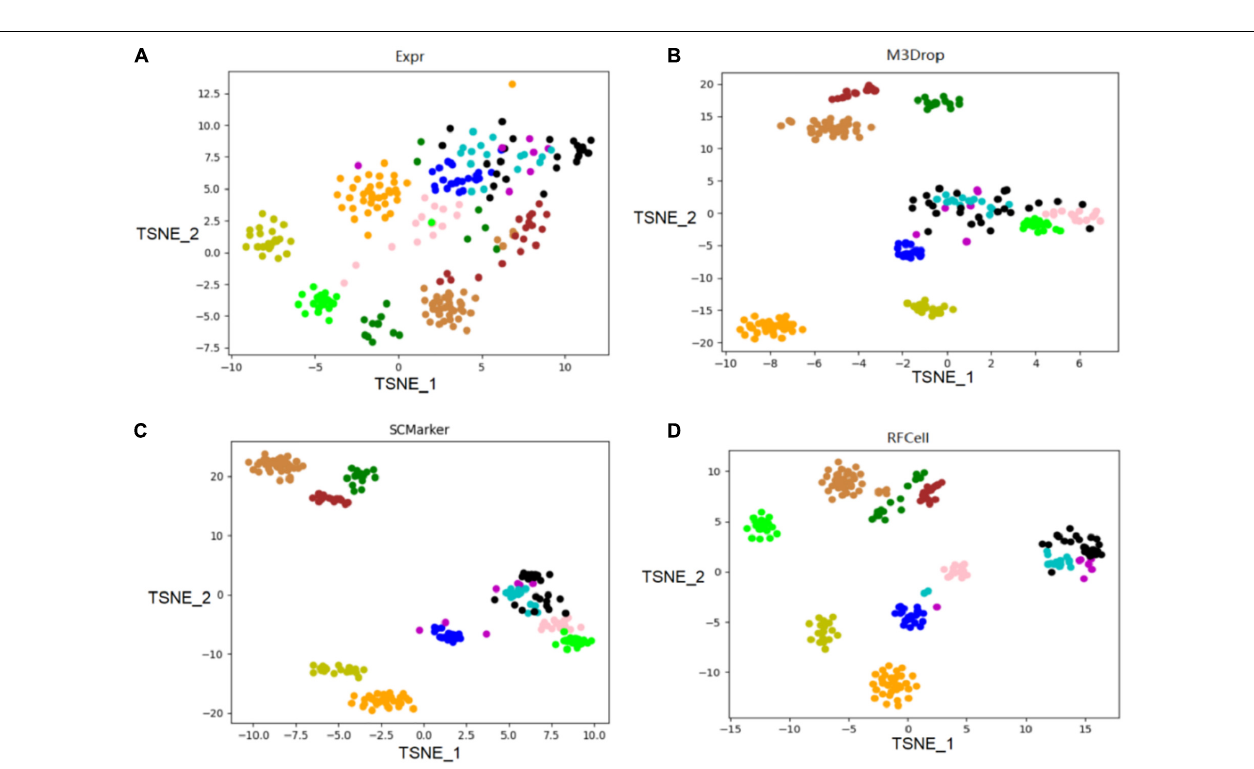
FIGURE 4 | On the published pollen data of the scRNA-seq data set, the gene sets obtained by the three gene selection methods (Expr, M3Drop, and SCMarker) and the gene sets obtained by the RFCell gene selection method were compared. The visualization diagrams respectively show the gene sets obtained by the four gene selection methods: (A) Visualization of the results of Expr gene selection; (B) Visualization of the results of M3Drop gene selection; (C) Visualization of the results of SCMarker gene selection; (D) Visualization of the results of RFCell gene selection.